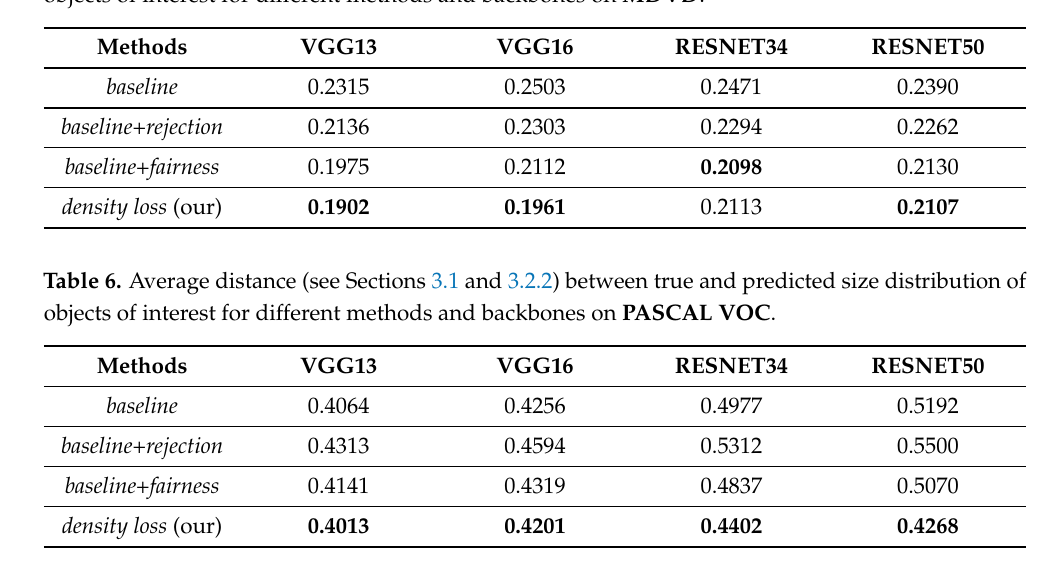
objects of interest for different methods and backbones on MDVD .